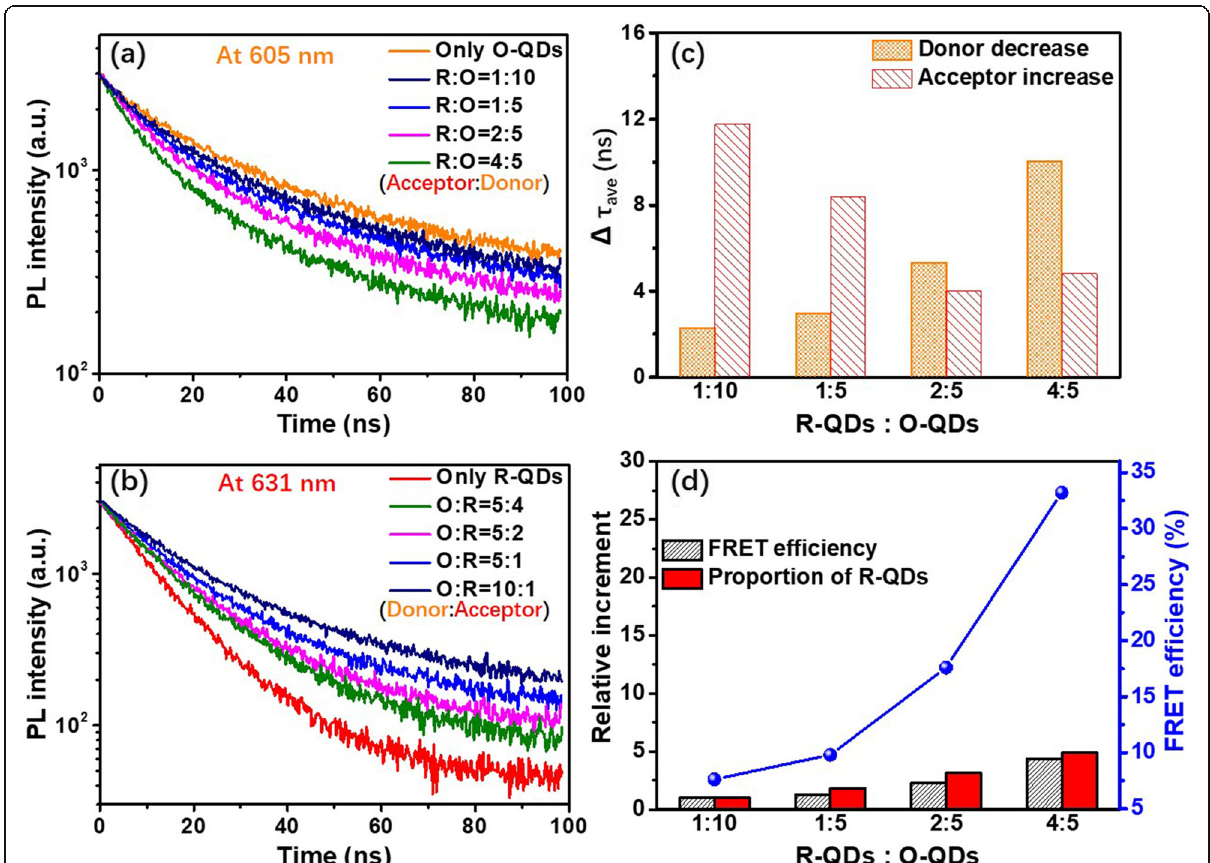
Fig. 5 TRPL decay curves of composite-QD thin films with different ratios of R-QDs to O-QDs at donor peak emission wavelength ( a ) and acceptor peak emission wavelength ( b ). The variation of donor decrement lifetime and acceptor increment lifetime ( c ). The comparison of relative increment between in FRET efficiency and R-QDs proportion, and the calculated FRET efficiency under the different ratios of R-QDs to O-QDs ( d )